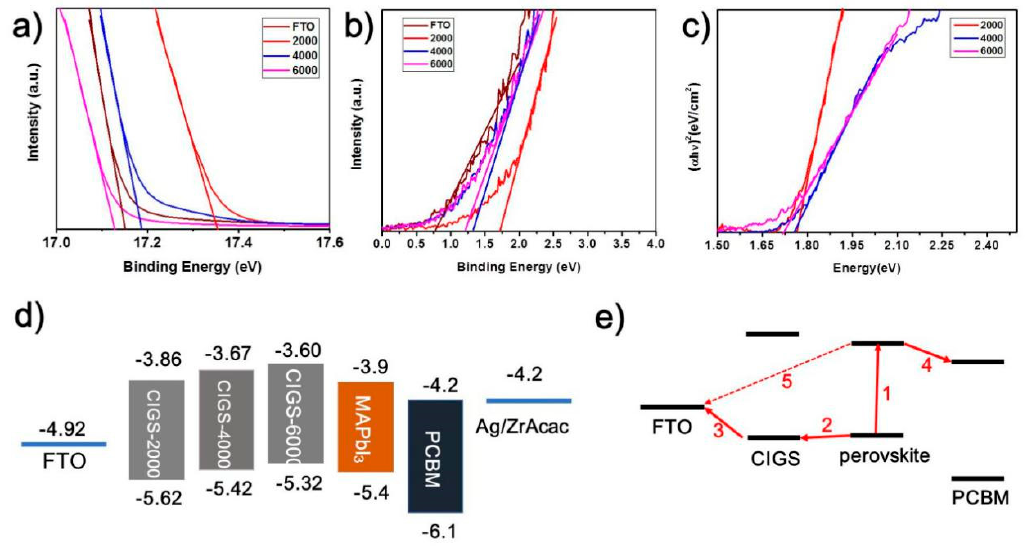
Figure 6. ( a ) and ( b ) are the UPS spectra of the CIGS thin films (spin coated at 2000 r.p.m., 4000 r.p.m., 6000 r.p.m., respectively) and FTO. ( c ) Tauc plots extracted from their corresponding absorption spectrum presented in Figure 3g. ( d ) Schematic diagram of charge transfer process in devices. ( e )